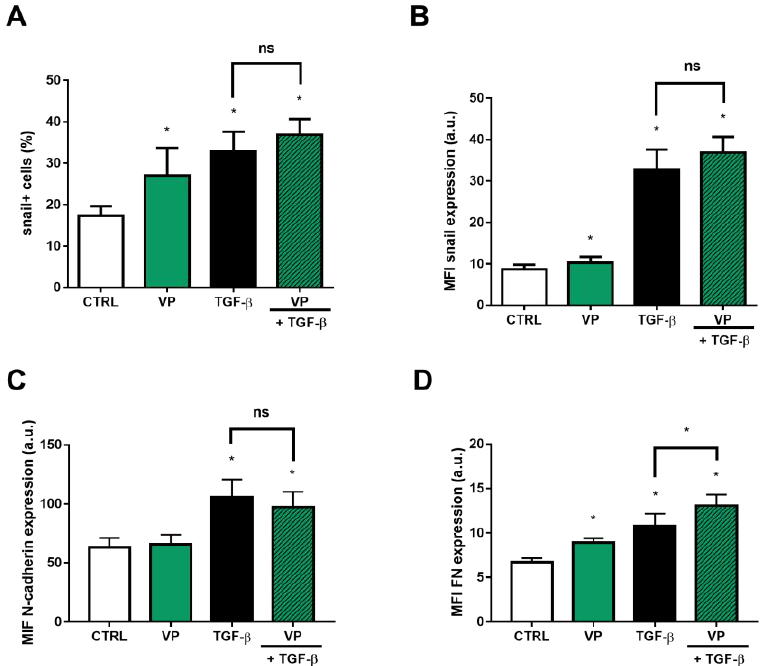
Figure 4. Verapamil changes expression of proteins related to epithelial-mesenchymal transition (EMT). A549 cells (1 × 10 5 cells/mL) were incubated with 10 µM verapamil for ABCB1 inhibition in the absence or presence of 5 ng/mL TGF- β for EMT induction. After 48 h, the cells were stained with antibodies against ( A , B ) snail, ( C ) N-cadherin and ( D ) fibronectin (FN) and ( A ) percentage of positive cells and ( B – D ) protein expression were evaluated by flow cytometry. Expression is represented by median fluorescence intensities (MFI). Bars represent mean + SEM, and the values of significance were represented by (*) for p < 0.05 from at least four independent experiments. ns = not significant.